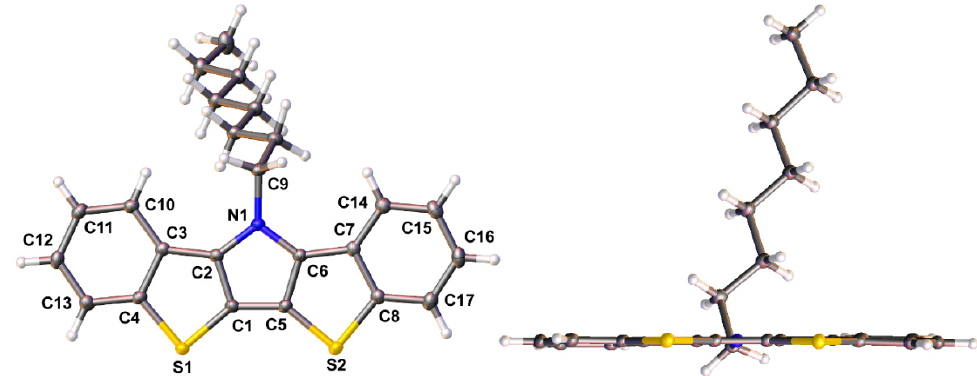
Figure 3. Face and edge ellipsoid plots of N ‐ octylbis[1]benzothieno[3,2 ‐ b :2 ′ ,3 ′‐ d ]pyrrole 1g at the 50% probability level.